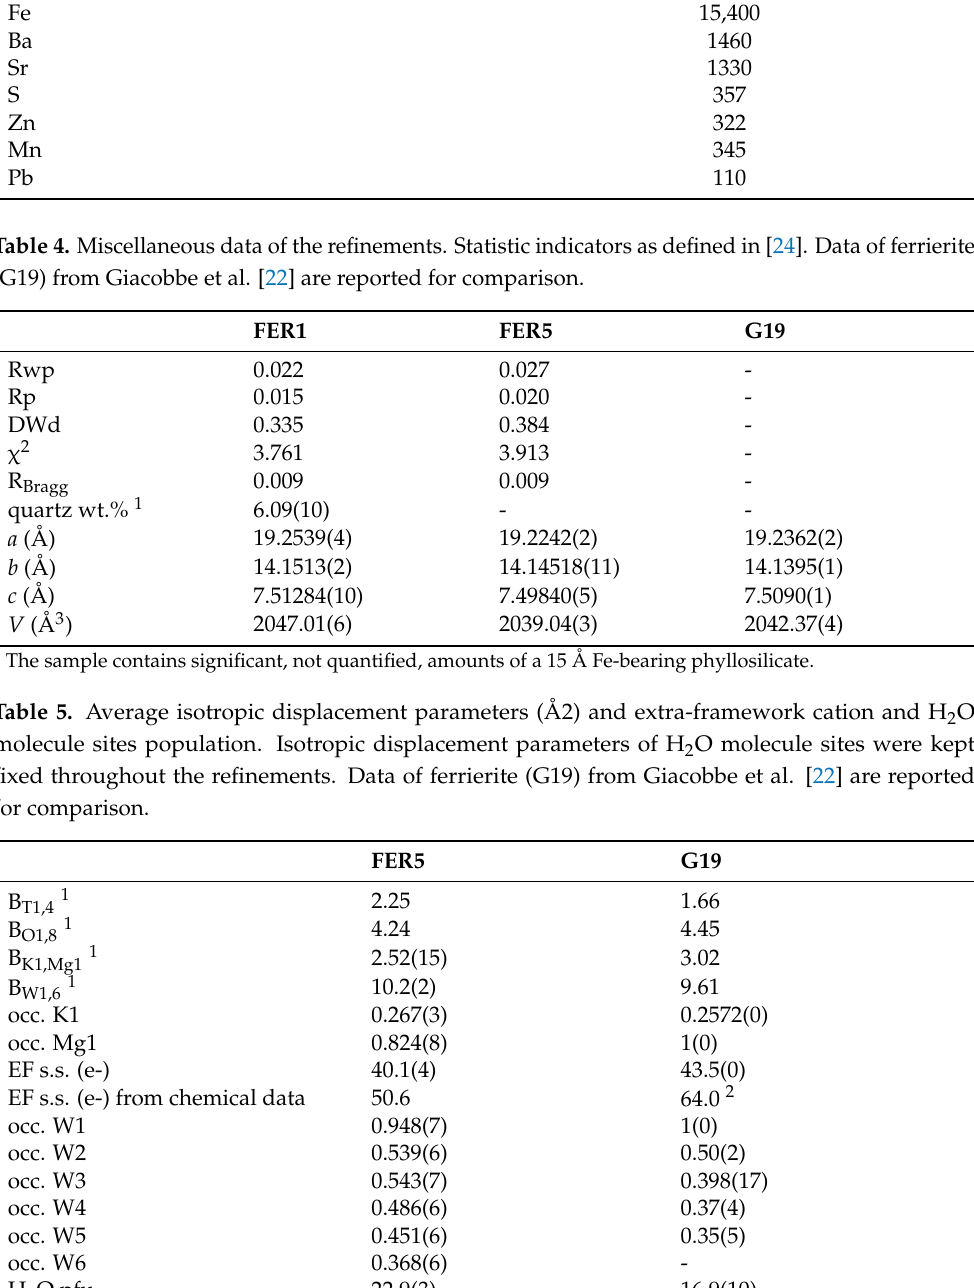
Table 3. ICP-AES chemical analyses of selected minor elements (mg/kg) of the FER1 sample. Elements